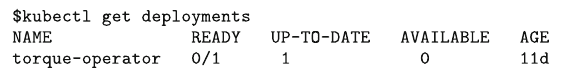
existence of one or more shared login